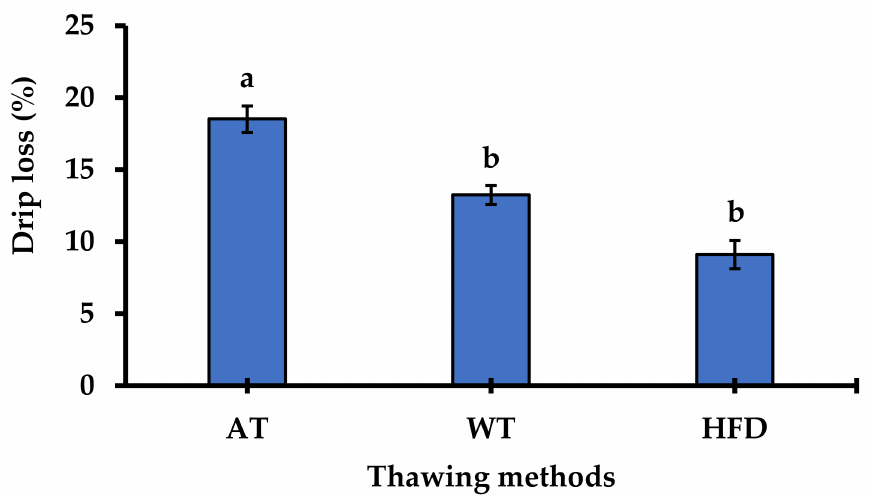
Figure 2. Drip loss (%) of frozen Alaska pollack roe (APR) after thawing using air thawing (AT), water thawing (WT), and high-frequency defrosting (HFD). The data are shown as the mean ± standard error of the mean. Means with different letters differed significantly between thawing methods (Tukey’s test, n = 3, p <